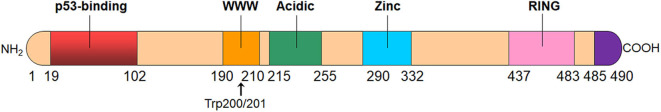
The structure of MDMX protein. MDMX has four conserved domains, including an N-terminal p53-binding domain, the central acidic domain, the zinc-finger domain, and the C-terminal RING domain. MDMX also has an autoinhibitory sequence element, i.e., WWW motif, which inhibits the MDMX-p53 interaction. The C-terminal tail (residues 485–490) of MDMX is also important for the formation of MDM2-MDMX heterodimer.